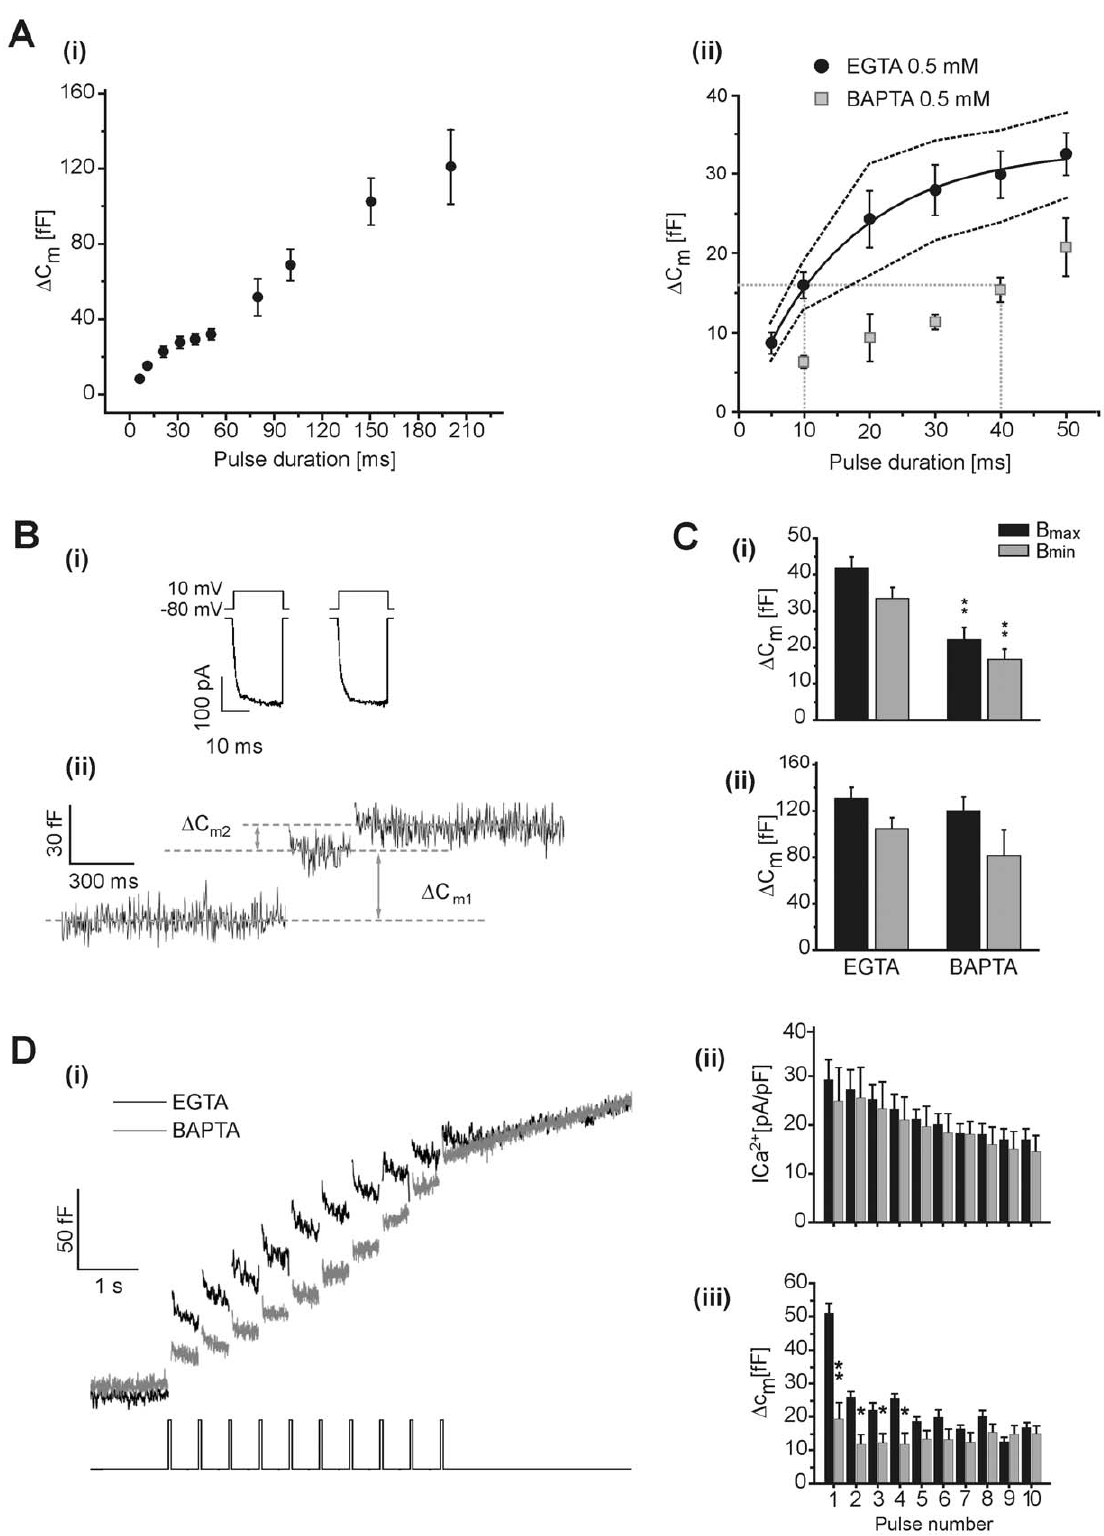
Figure 1. IRP exocytosis is tightly coupled to Ca 2 + source. A. (i) Summary of capacitance increases after stimulation with depolarizing pulses of different lengths, between 5 and 200 ms, in control condition (with EGTA 0.5 mM in the internal solution). Note that there is a clearly defined initial component, which saturates approximately between 30 and 50 ms pulses. (ii) The black circles in the figure on the right is an expanded representation of this initial component (n=116), while the gray squares represent experiments performed with BAPTA (0.5 mM) as exogenous internal buffer (n=53). The results obtained with EGTA were fitted with a single exponential function of the form A. (1 2 e 2 t/ t ) (A=33 6 1 fF,